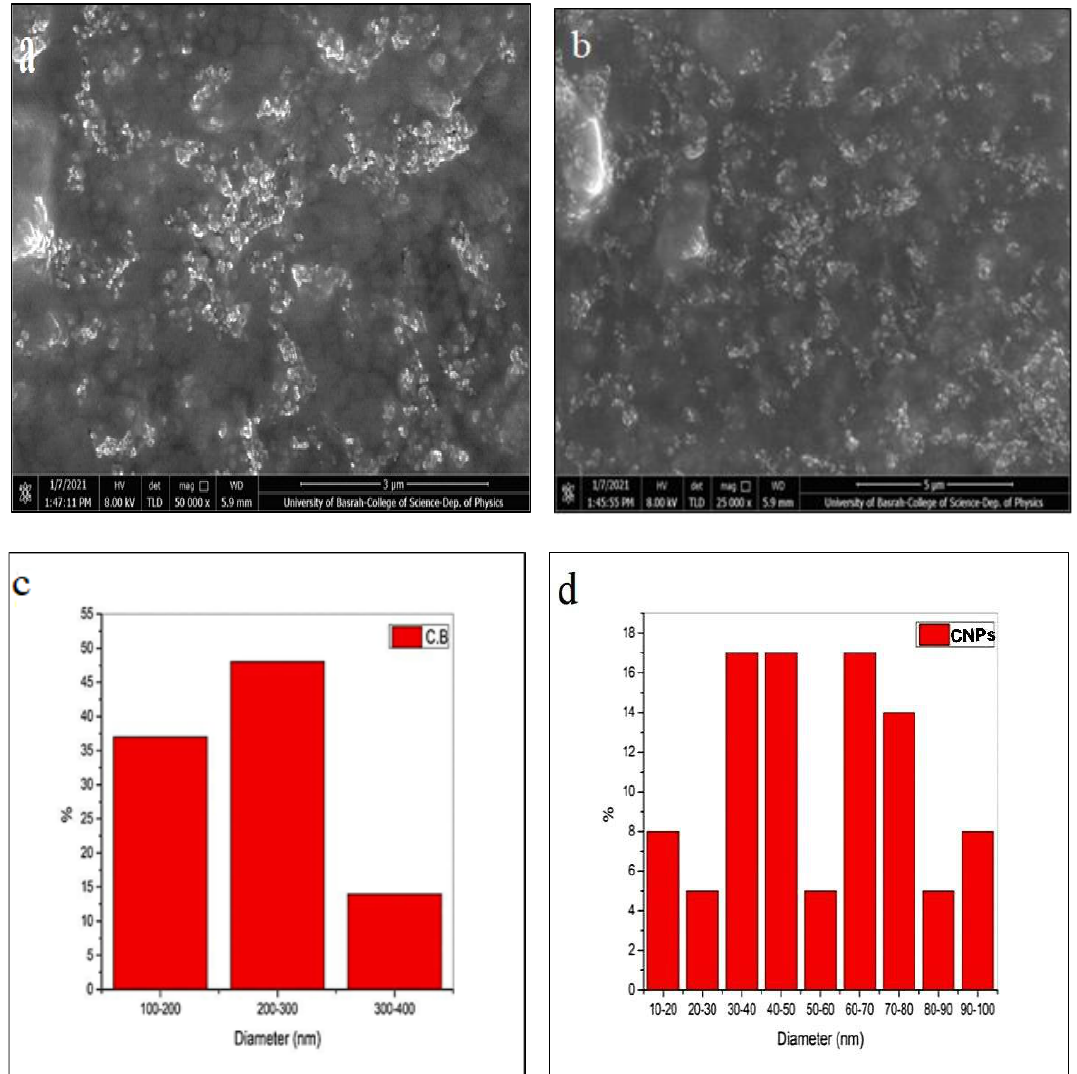
Figure 4: FESEM of: (a) CB/silicon glue film and (b) CNPs/silicon glue film. Particle size distribution of: (c) CB and (d)